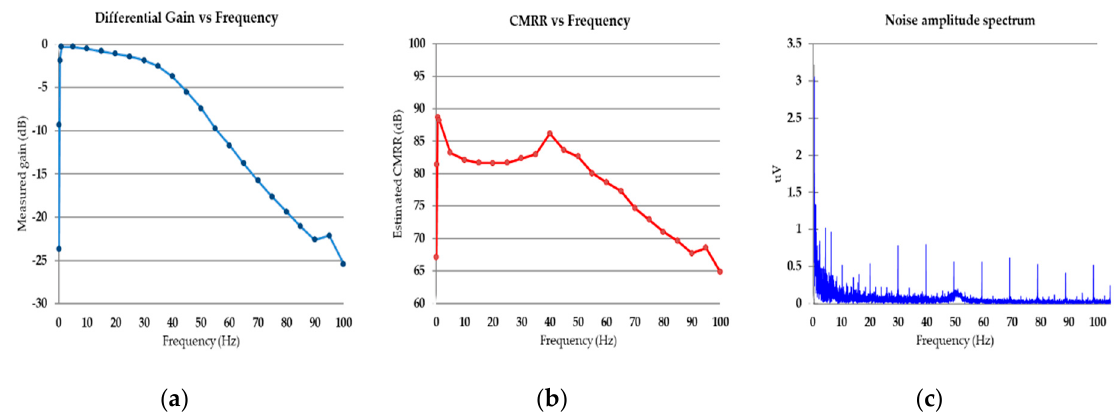
Figure 18. ECG amplifier characterization: ( a ) measured system gain in dB; ( b ) estimated CMMR vs. frequency; (c) noise amplitude spectrum.